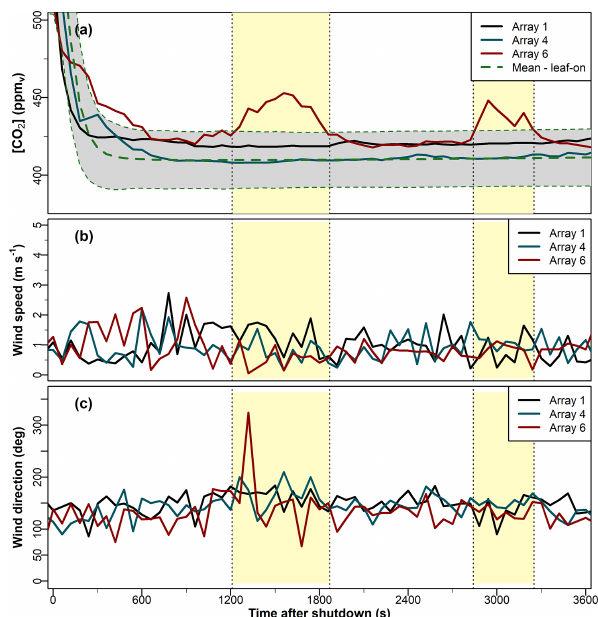
Figure 10. Time series of 1min averages in the (a) CO 2 mixing ratio, denoted [CO 2 ] (Sect. 2.1); (b) wind speed; and (c) wind di- rection after shutdown on 17 August 2020. In panel (a) , the dashed green line shows the mean [CO 2 ] at each 1min time step after shut- down for the leaf-on period (Sect. 2.2 for observational details). The grey-shaded confidence interval in panel (a) shows 1 standard devi- ation on either side of the mean. The standard deviation is presented here to emphasise that these venting events are not simply symp- toms of the variability of the [CO 2 ] observations; in this dataset, it is larger than the other two measures of statistical variability used in this paper (the IQR and D med ). The yellow-shaded rectangles indicate the approximate duration of the venting